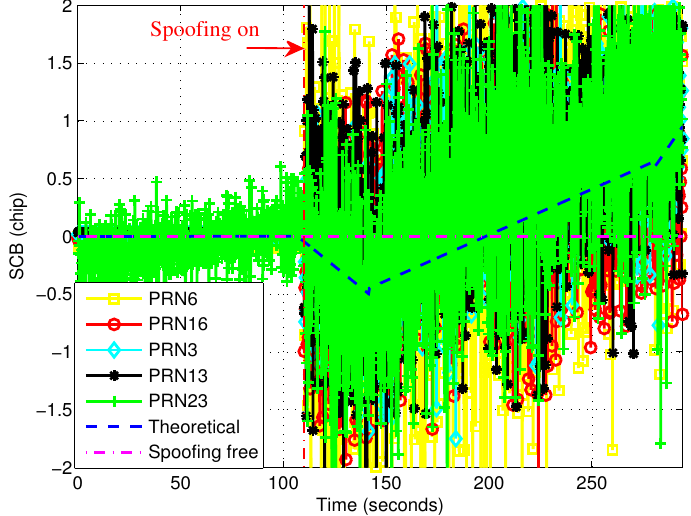
Figure 3. Comparisons between experimental SCB curve and theoretical SCB